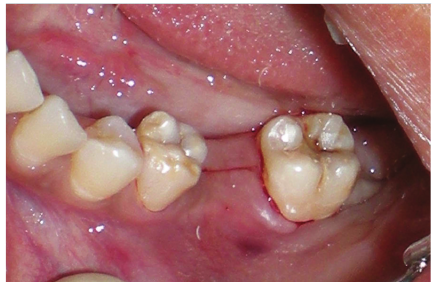
Figure 1: Preoperative view of the posterior left first molar, number 36.